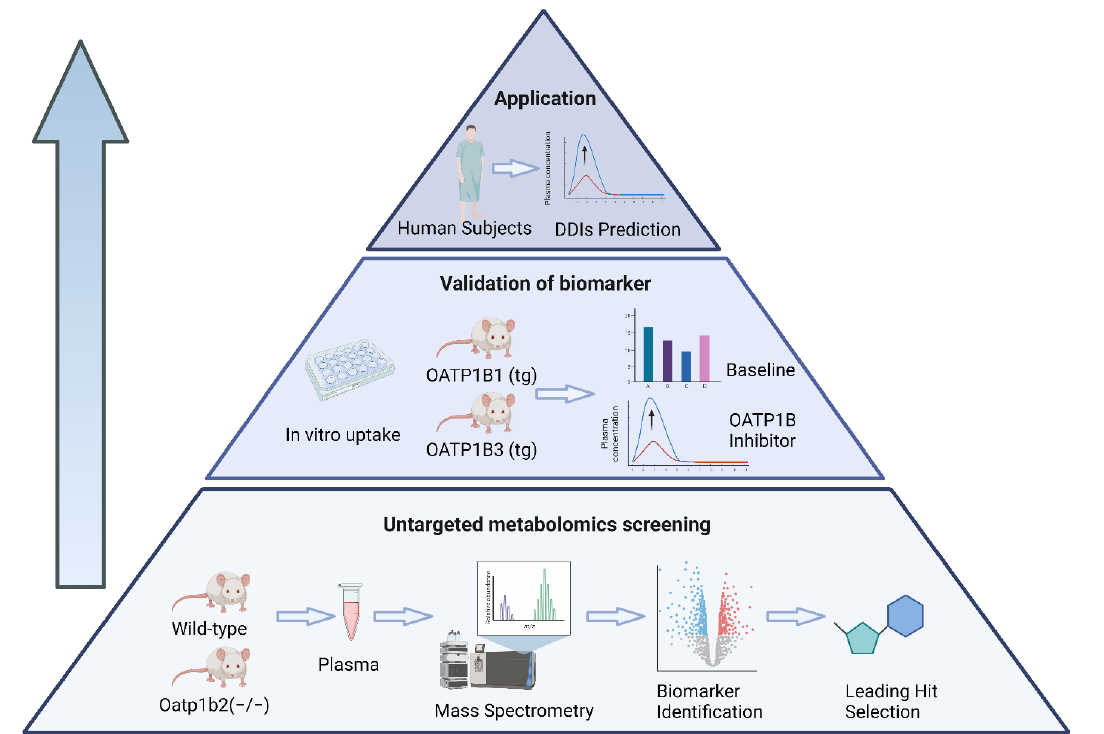
Figure 1. Schematic depiction of a bottom–up, untargeted metabolomics screening approach for predicting OATP1B-type transporter-mediated DDI liabilities.